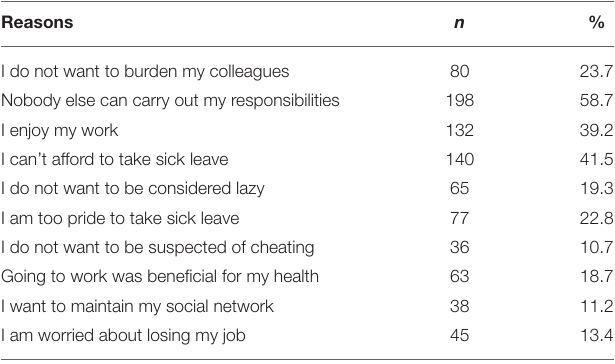
TABLE 4 | Description of reasons for presenteeism among the self-employed ( n =